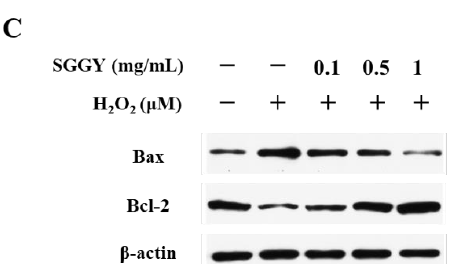
Figure 2. SGGY inhibited H 2 O 2 -stimulated apoptosis in SH-SY5Y cells. Cells were pre-incubated with SGGY (0.1, 0.5, and 1 mg/mL) for 12 h and subsequently exposed to 900 μM H 2 O 2 for 2 h. ( A ) Apoptosis was analyzed using Annexin V-FITC/PI staining by flow cytometry. The graphs contain the percentage of necrotic cells (Q1), late apoptotic cells (Q2), early apoptotic cells (Q3), and normal cells (Q4) relative to the total cells. (B ) Quantitative analysis of the apoptosis ratio of early and late apoptotic cells. ( C ) The expression of Bcl-2 and Bax were explored by Western blotting. * p < 0.05 vs. control group, and # p < 0.05 vs. H 2 O 2 group.